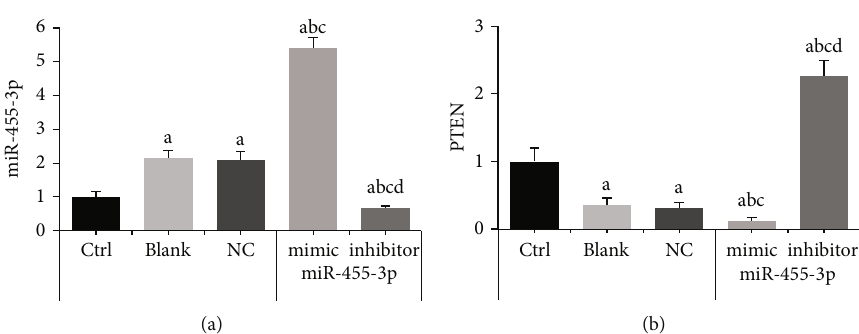
Figure 2: Comparison of expressions of miR-455-3p and PTEN in BMSCs. Note: (a) miR-455-3p. (b) PTEN. A, B, C, and D meant P < 0 : 05 in comparison to the Ctrl, blank, NC, and mimic groups,